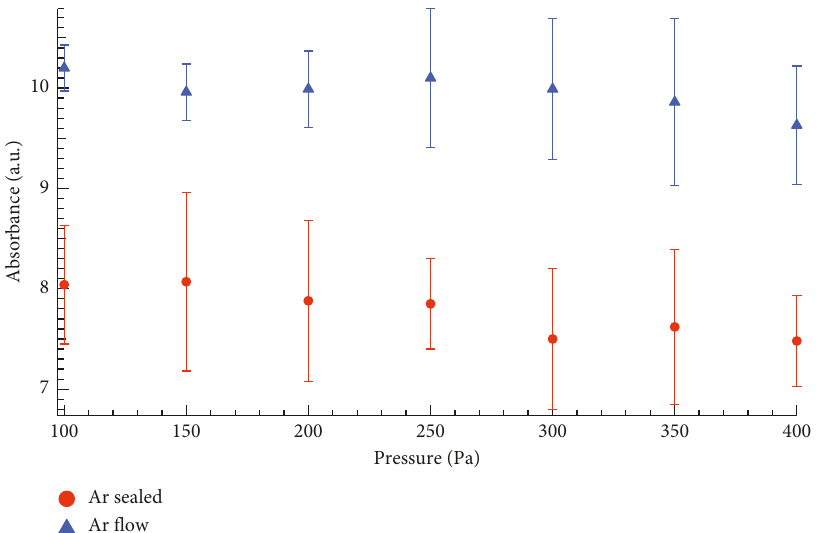
Figure 7: Absorbance of Ar in flowing gas and sealed cell cases at 20mA.